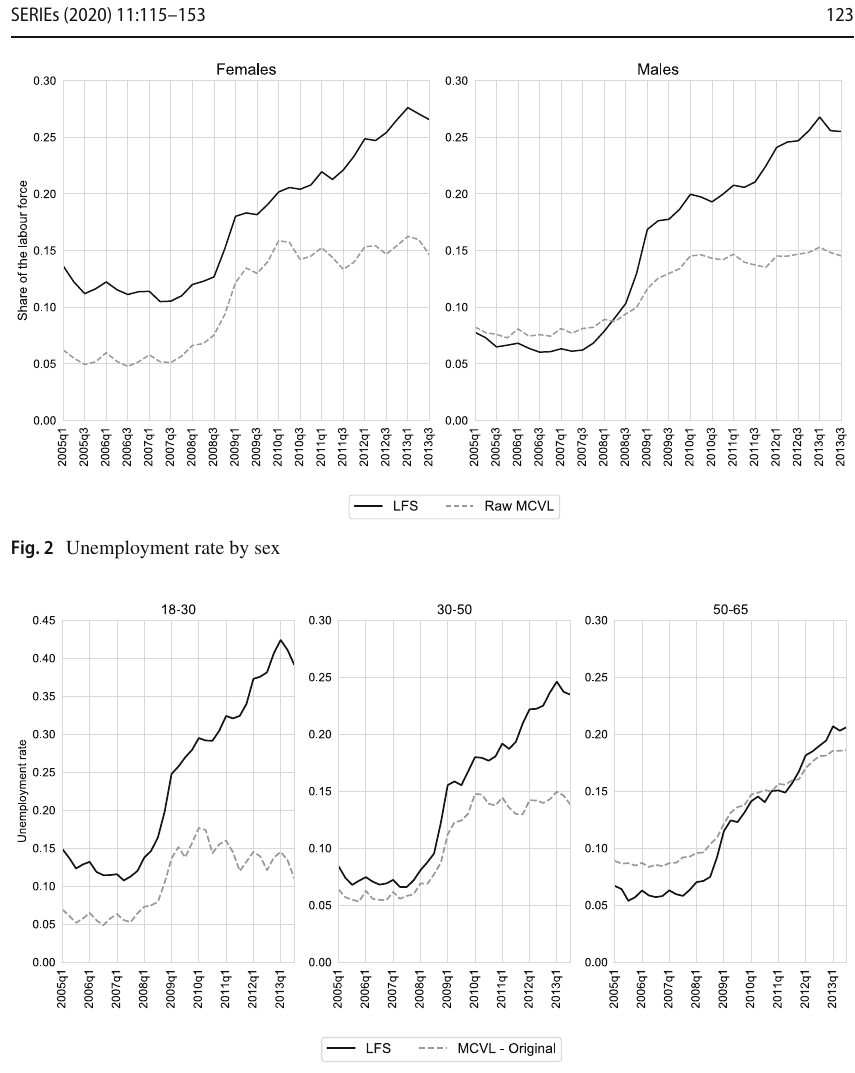
Fig. 3 Unemployment rate by age. Source : MCVL and the